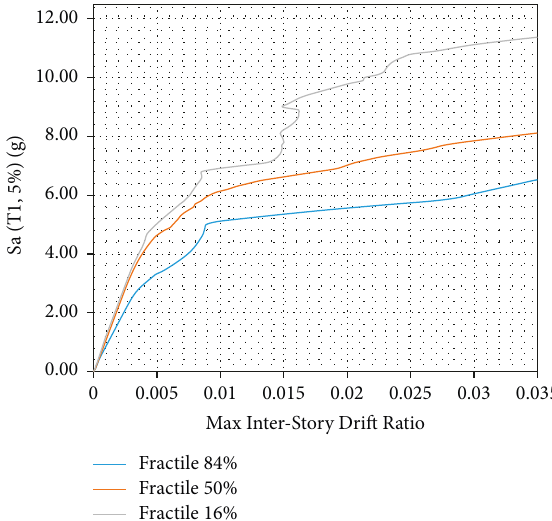
Figure 25: Fractile curves of the steel-HSS braced portal frame.